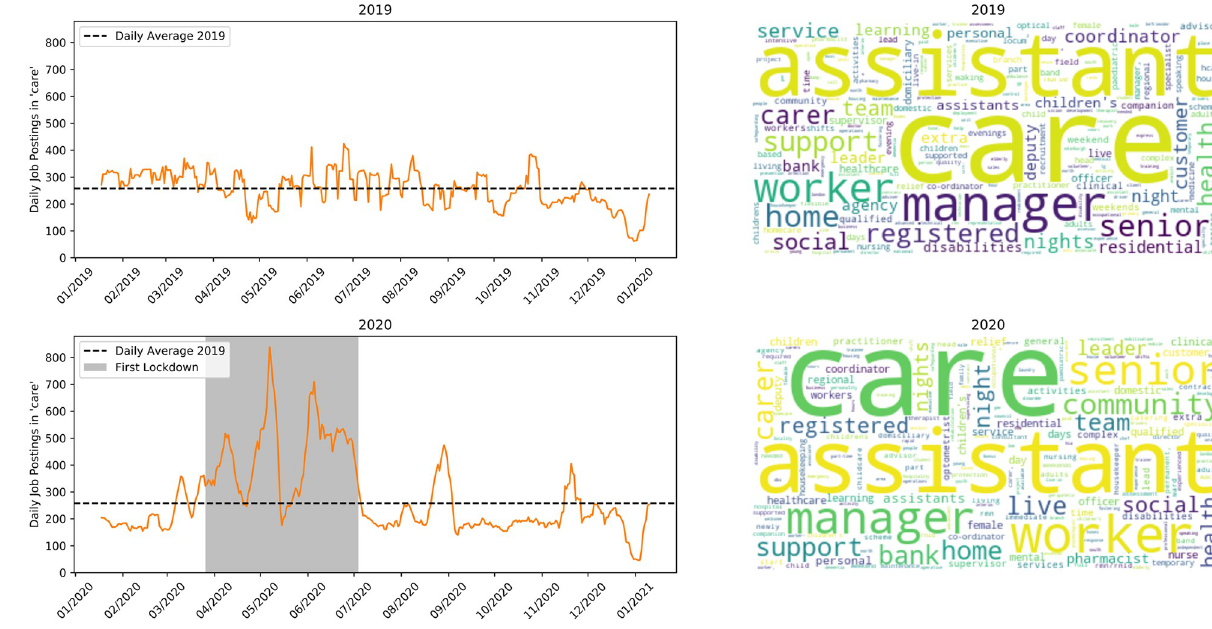
Fig 7. Jobs matching ‘care’. Top row is 2019, bottom is 2020.